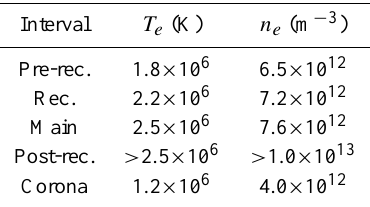
Table 1. Plasma parameters inside the reconnecting region. Interval T e (K) n e (m − 3 ) Pre-rec.